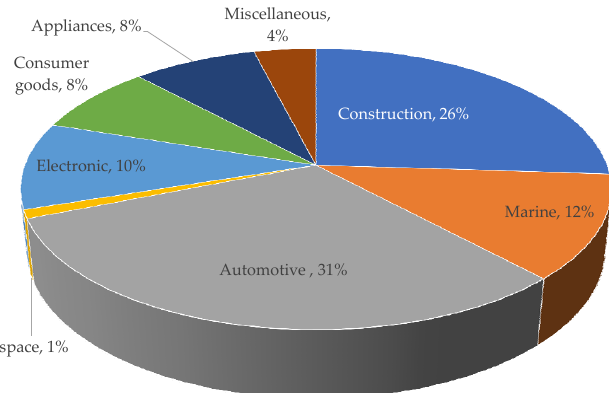
Figure 1. Market share of Fibre Reinforced Polymer (FRP) by application [4,5].